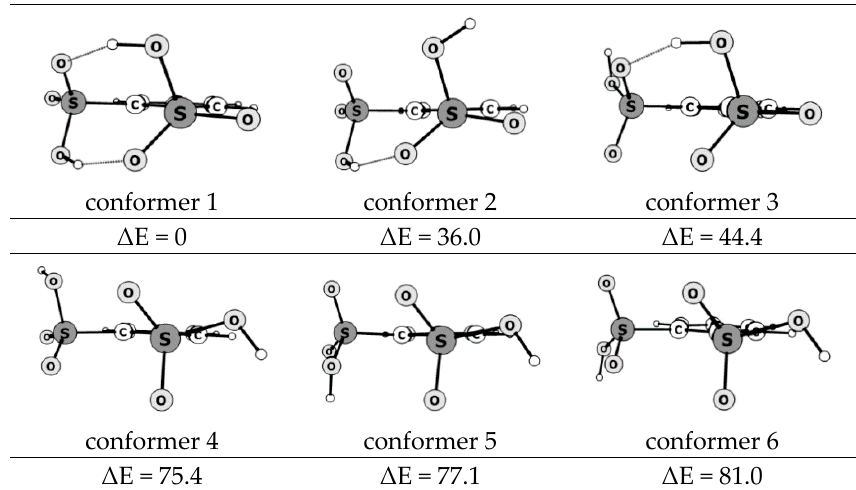
Figure 10. The structure of the 2-SO 3 H-BSAconformers and their relative energies ( Δ E, kJ mol − 1 ).